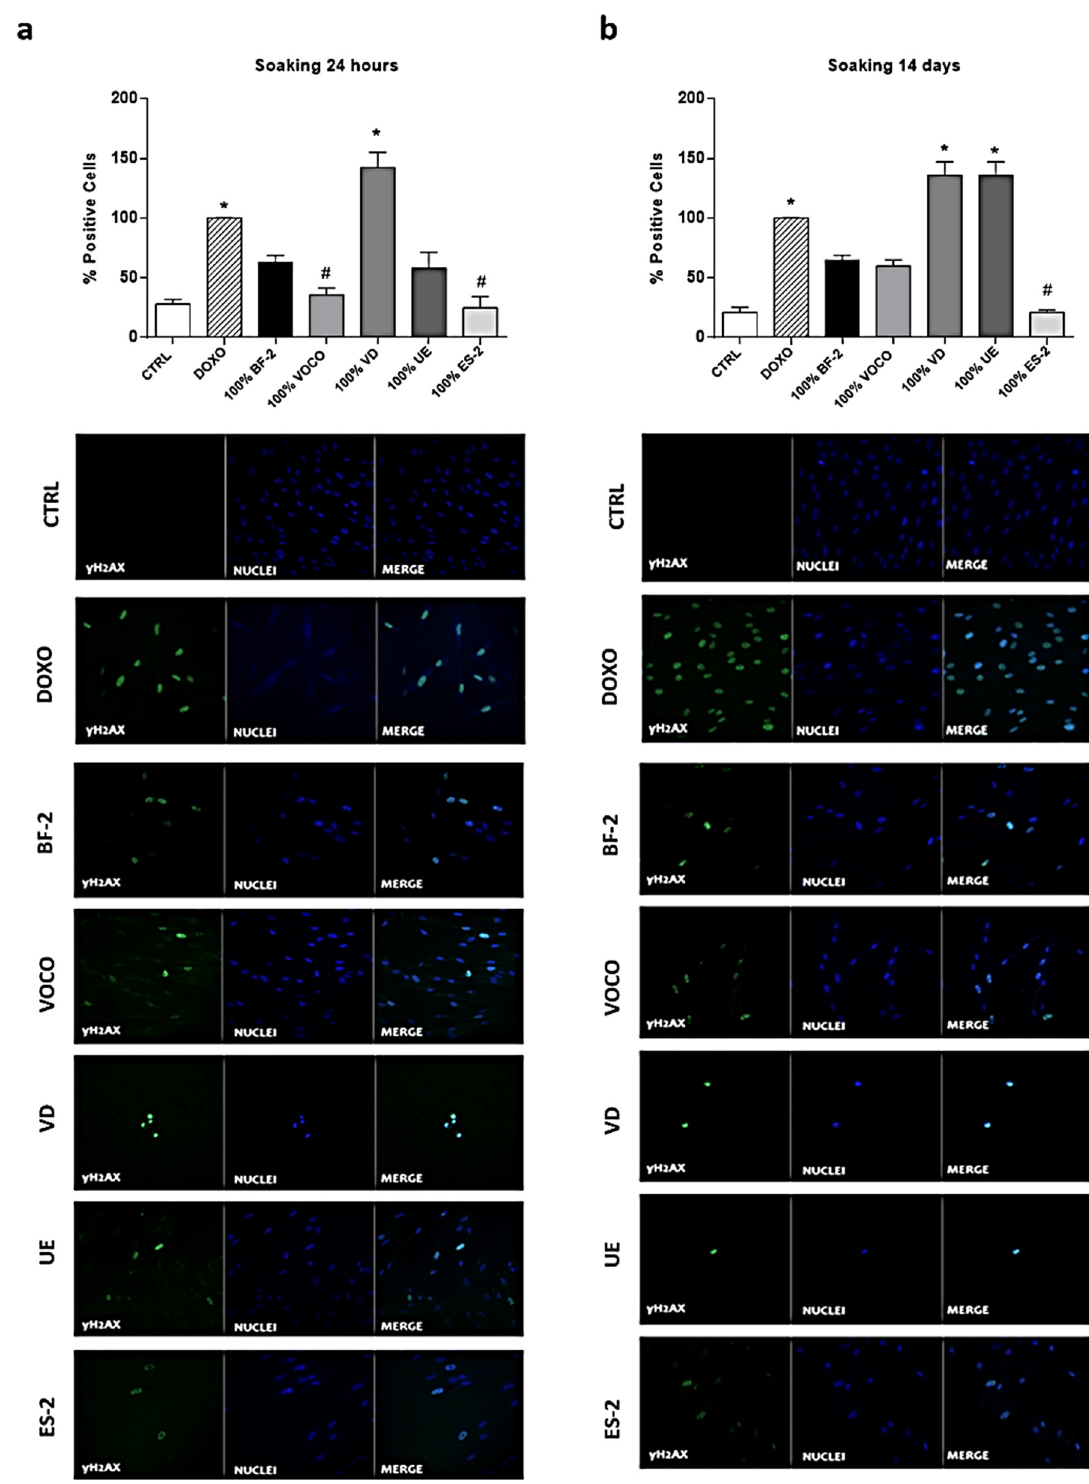
Figure 6. DNA damage. Graphs and representative fluorescence images show the expression of γ H2AX in hGDFs (stained with anti- γ H2AX, DAPI, and merged; 40x) following 48 h of treatment with the ( a ) 24-hour and ( b ) 14-day CR-derived extracts, undiluted (100%). Results are expressed as mean ± standard error (SEM) ( n ≥ 3). Data, calculated as percentage (%) of positive cells for γ H2AX, were obtained by analyzing at least three different fields for each image with ImageJ software (NIH, USA). (* p < 0.05 vs. CTRL; # p < 0.05 vs. DOXO).